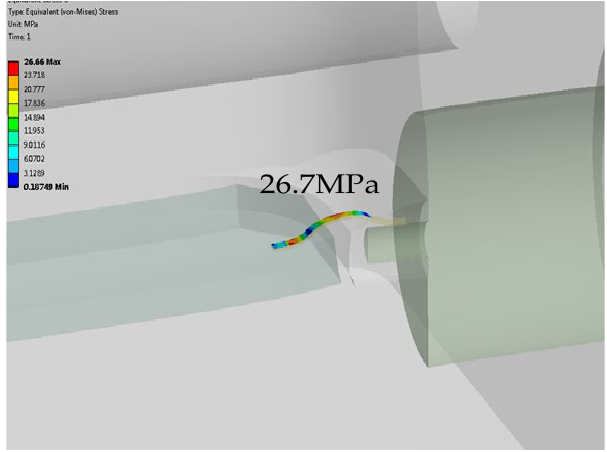
Figure 17. Analysis model of the novel horizontal interconnection.